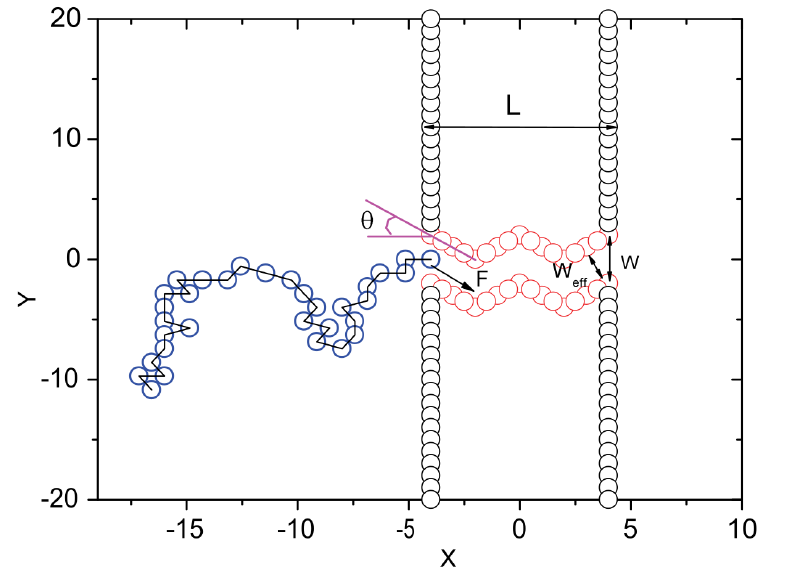
Figure 8. Scheme of a corrugated nanopore as proposed by Wang et al. [208], the corrugation is modeled via kinks in the pore. The translocation happens in the presence of an external driving force, F . Reprinted with permission from [208] copyright 2015 by American Institute of Physics